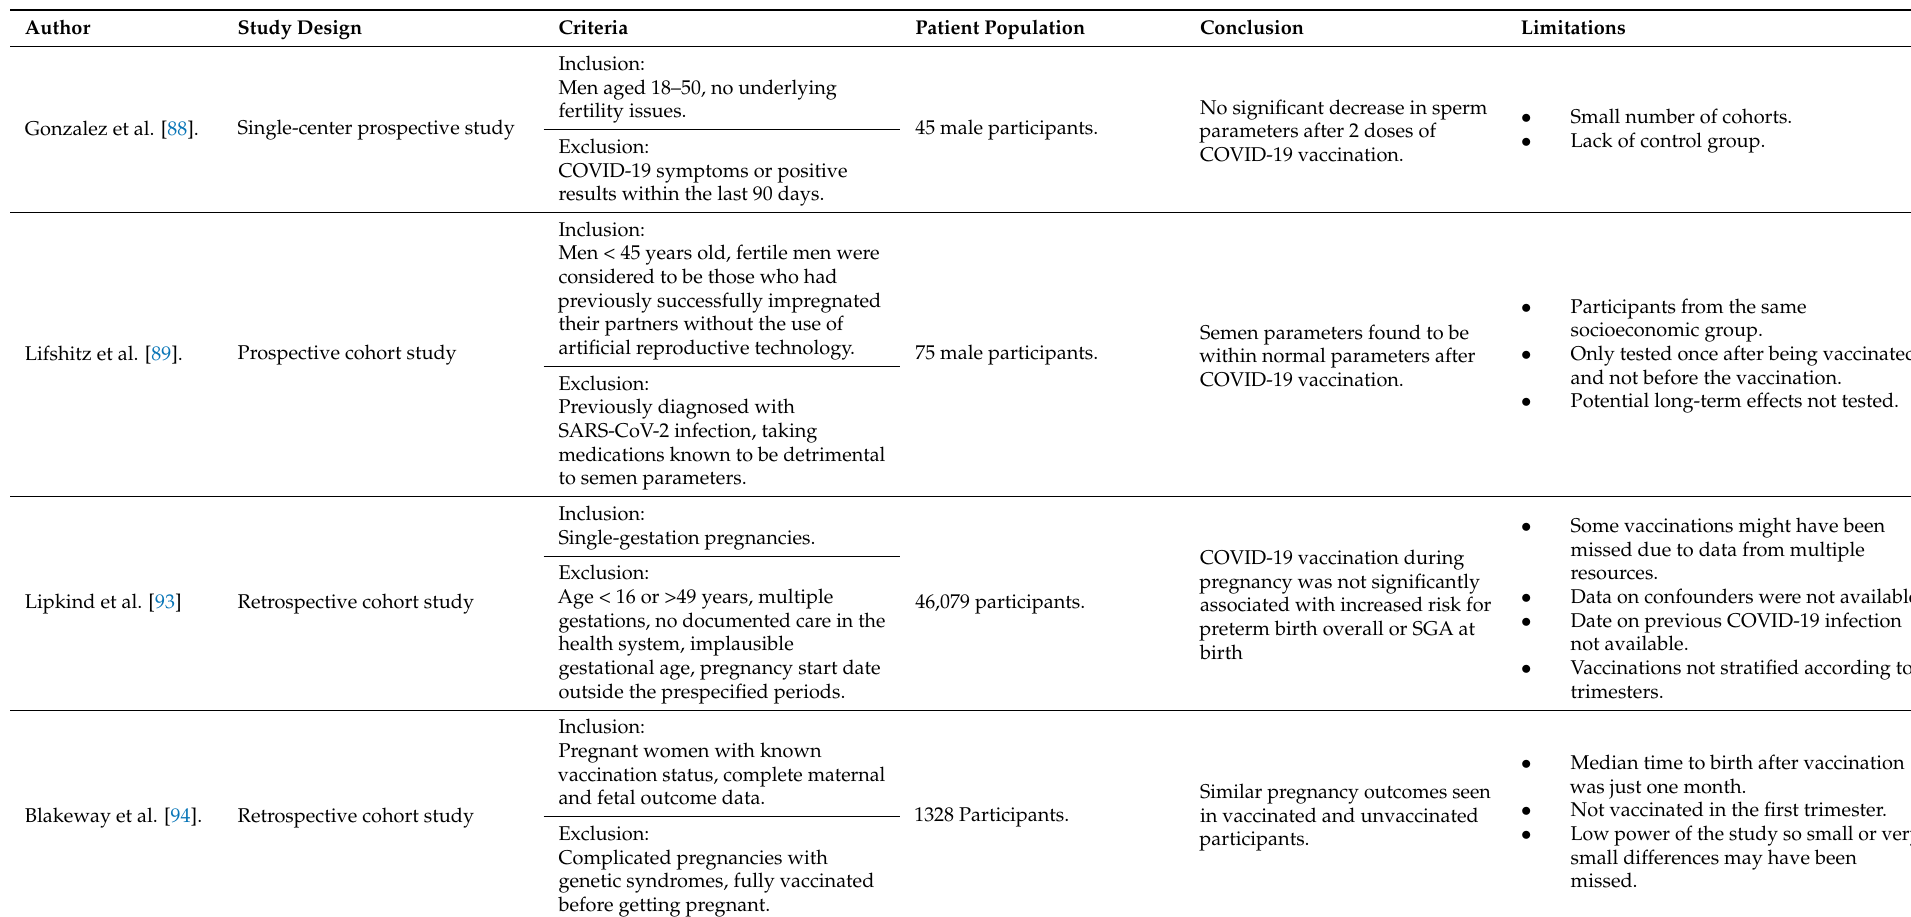
Table 2. Summary of studies addressing misinformation about COVID-19 vaccines and endocrine